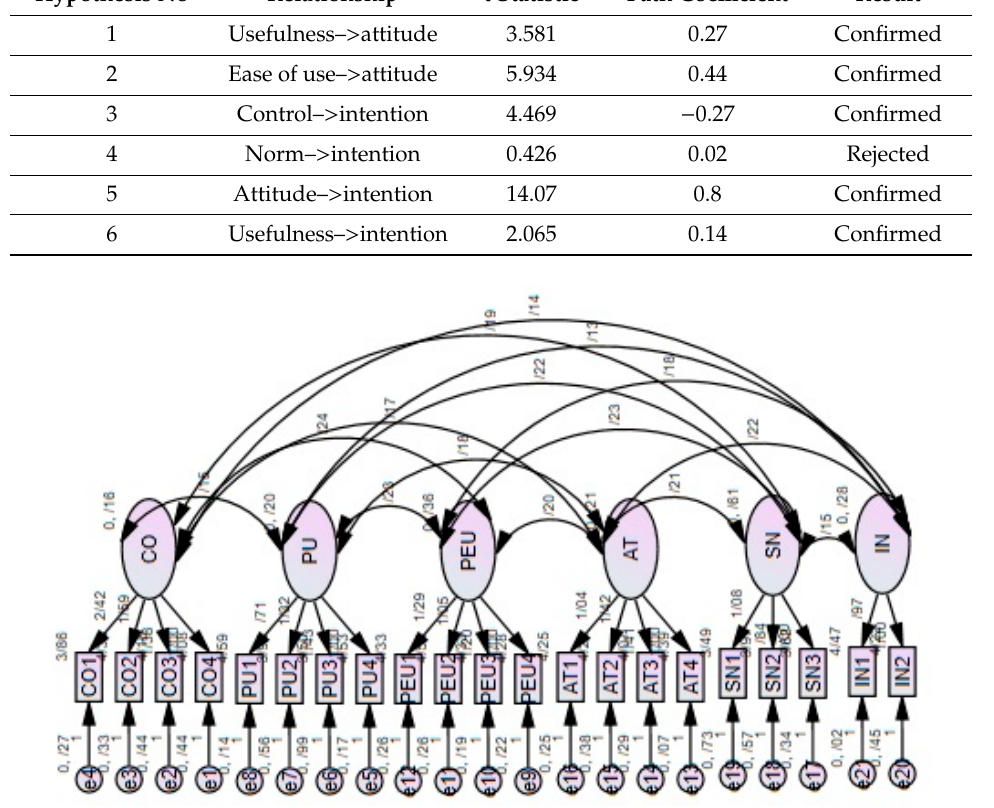
Figure 5. The fitness test for research’s hypotheses.